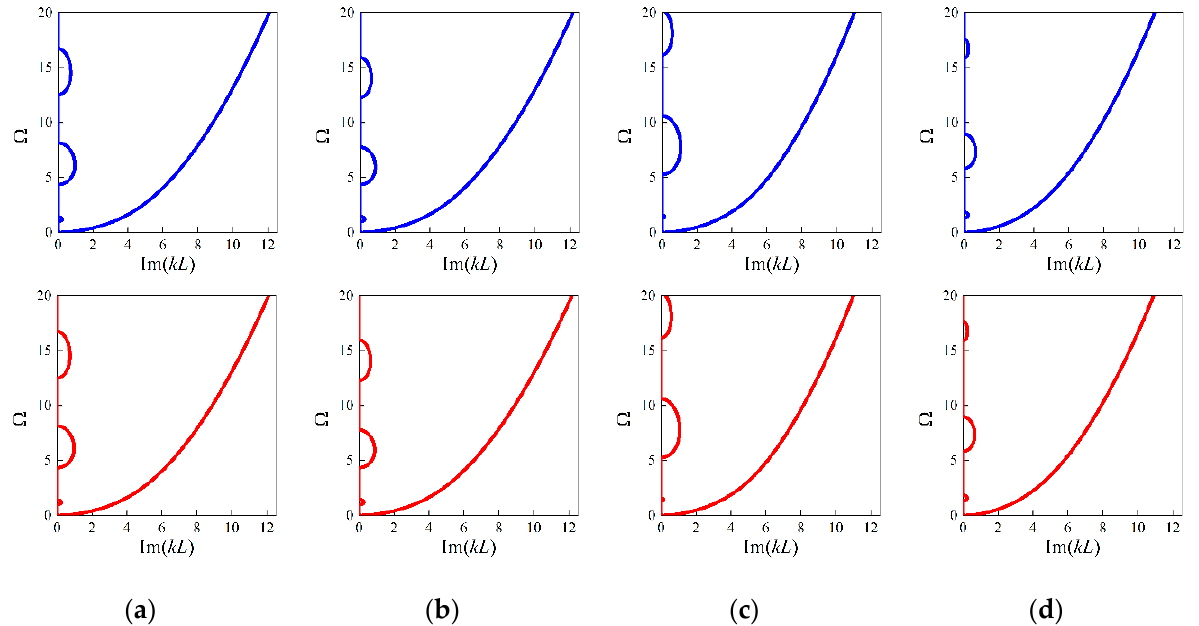
16 of 21 ( d ) Figure 12. Comparison results of the bounding frequencies and complex dispersion curves between the generated parameters and real parameters for random examples: ( a ) example 1; ( b ) example 2; ( c ) example 3; ( d ) example 4. The blue lines denote the results based on generated values and the red lines denote that of ground truth. From Figure 12 and Table 3, it can be found that even the generated PnC beam devi- ates from the real structure; perfect agreement is achieved between the real and imaginary panels of the complex band structures. Thus, it can be concluded that the established deep learning model can not only accurately produce feasible structures but also retain the di- versity of micro PnC beams for desired dispersion relations incorporating size-dependent behavior. 3.4. Inverse Design with Different Unit Cell Lengths Adopting the NN without the well-trained forward path, the relative mean errors between the bounding frequencies are 2.12%, 1.94% and 1.57% for L = 0.0005 m, L = 0.002 m and L = 0.01 m, respectively. As the unit cell length increases, the accuracy improves, which can be explained by the fact that the increasing length decreases the dependency of the length scale parameter on adjusting the band gaps. Once applying the tandem net- work, the relative mean errors are calculated as 0.37%, 0.21% and 0.19%, definitely en- hancing the accuracy of the inverse design with respect to different unit cell lengths. Then, looking at the random examples accompanying specific unit cell length, when L is 0.0005 m, the predicted design parameters are 0.457, 0.3327, 0.9879; 0.0501, 0.4055,